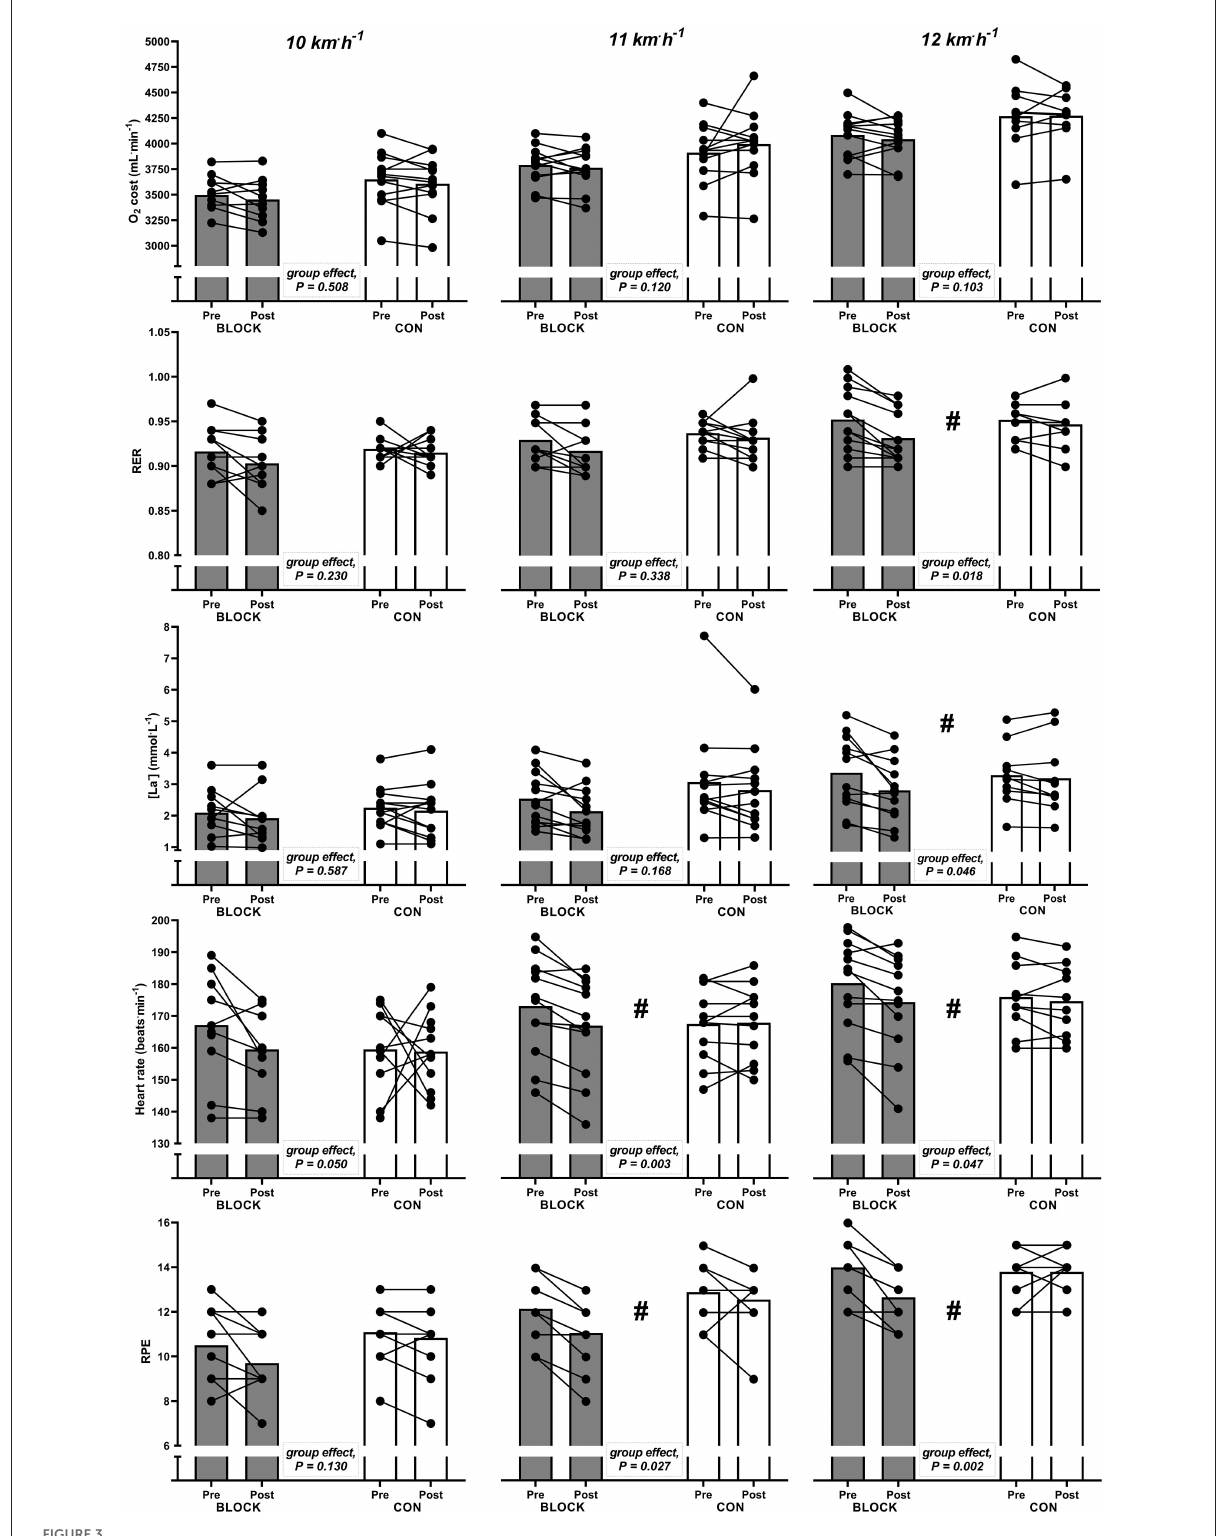
FIGURE3 Individual (dots) and group-average (bars) values for oxygen cost (O 2 cost), respiratory exchange ratio (RER), blood lactate concentration ([La − ]), heart rate, and rate of perceived exertion (Borg RPE, 6–20) responses during three different submaximal efforts [10 (left panel) , 11 (middle panel) , and 12 (right panel) km . h − 1 ] for the HIT block group (BLOCK) and the control group (CON) before (pre) and after (post) the intervention. # Significant different responses between BLOCK and